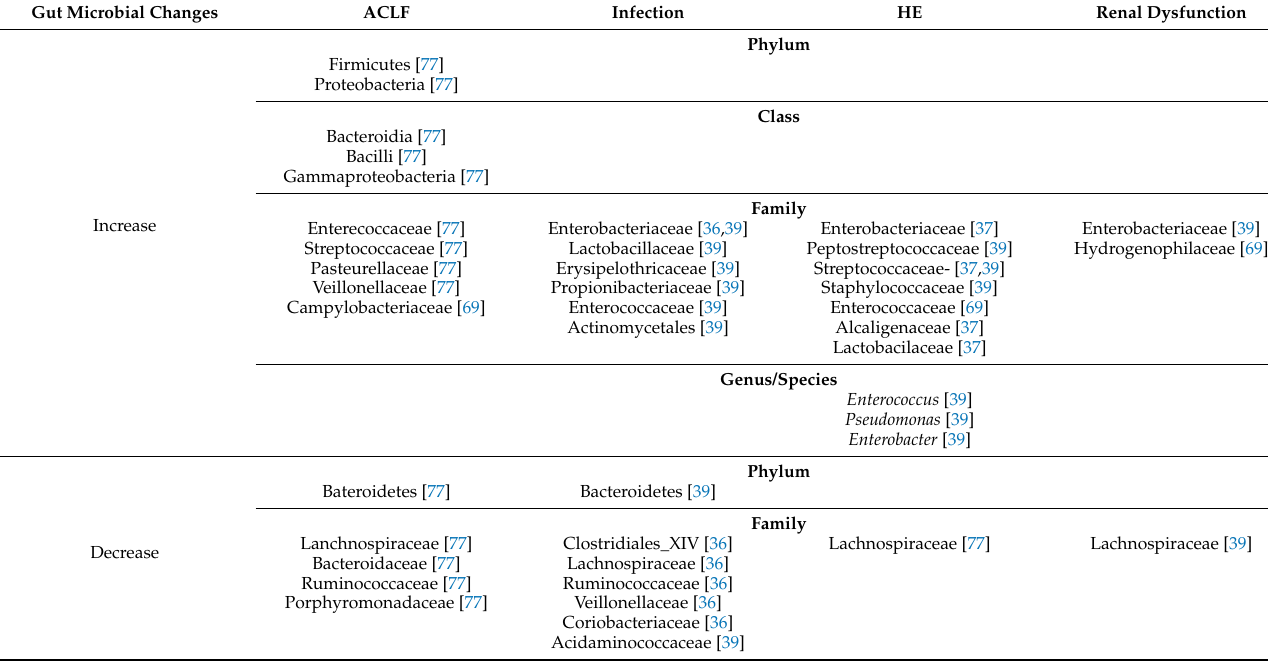
Table 2. The gut dysbiosis profiles in